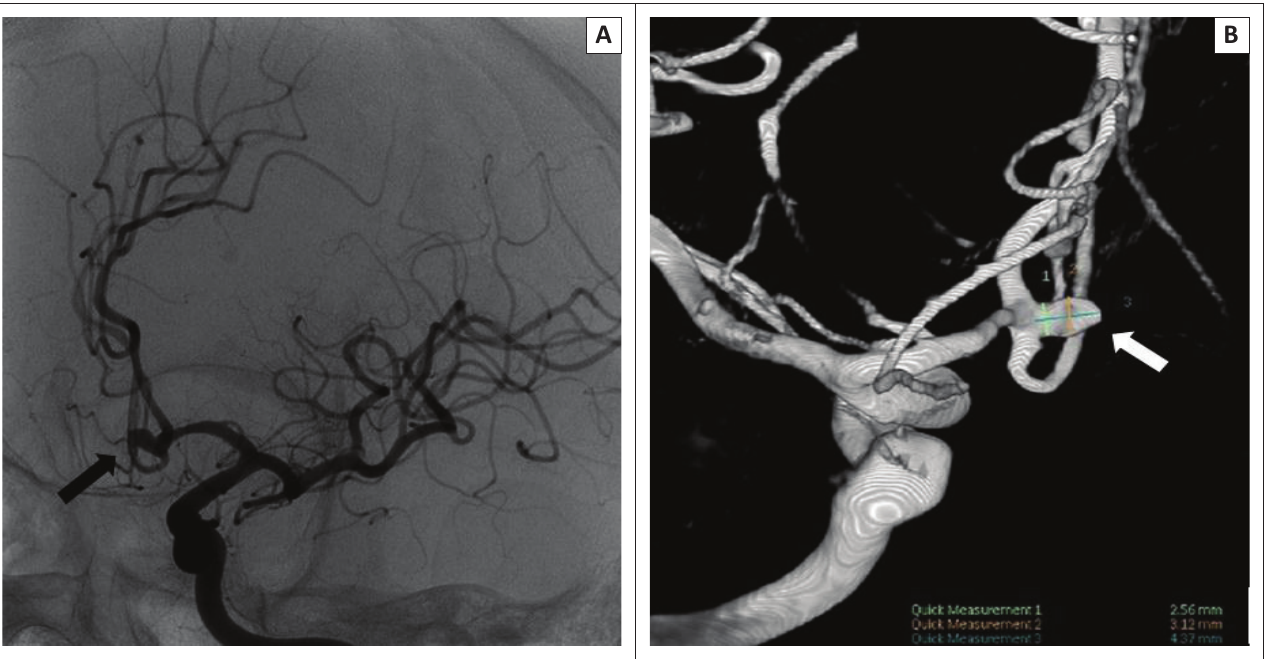
FIGURE 3: (a) Digital subtraction angiography following left internal carotid artery injection demonstrating an anterior communicating artery aneurysm (black arrow); (b) Three-dimensional screensaver image with measurement of an aneurysm and neck size (white arrow). The aneurysm was not amenable to endovascular treatment, because of its wide neck.